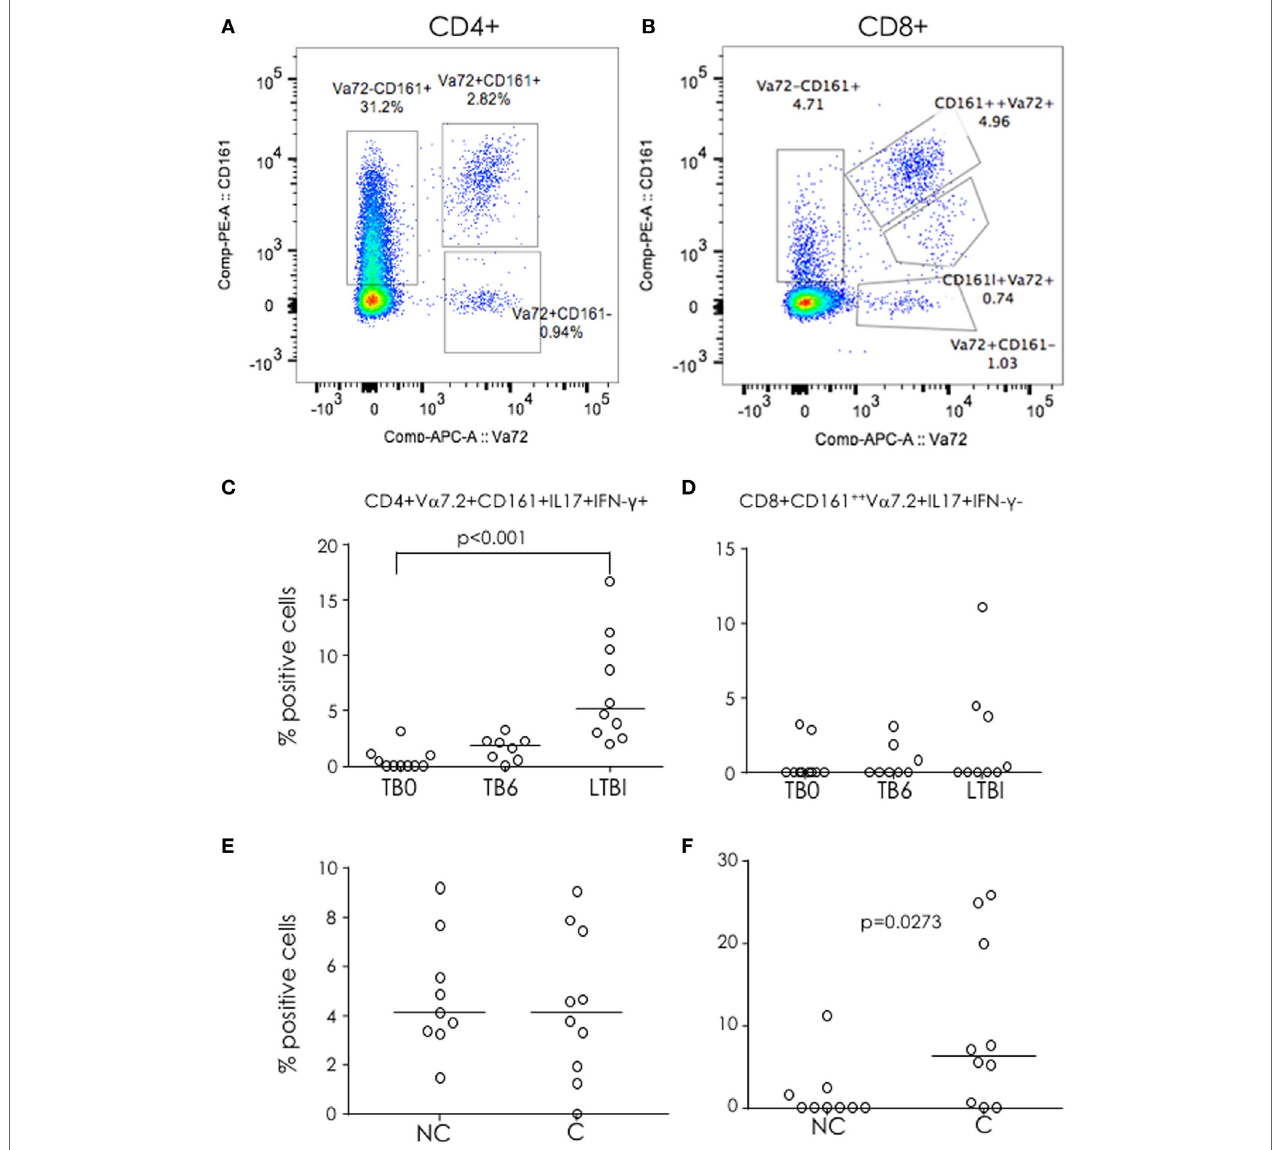
FigUre 4 | Functional V α 7.2 + CD161 + cells in tuberculosis (TB) infection and disease. (a,B) Representative FACS plots for CD161 and V α 7.2 expression within CD4 + (a) and CD8 + (B) cells. Three defined CD4 + subsets and four defined CD8 + subsets (boxes) were analyzed for cytokine production (IL-17 and IFN- γ ). Proportion of IL-17 + IFN- γ + CD4 + V α 7.2 + CD161 + (c,e) and IL-17I + FN-g + mucosal-associated invariant T cells (D,F) in TB cases before (TB0) and after treatment (TB6) and latently TB infected (c,D) and in IGRA non-converters (NC) and converters (C) (e,F) . Data were analyzed using Kruskal–Wallis test (c,D) or Mann–Whitney U -test (e,F) . Bar indicates